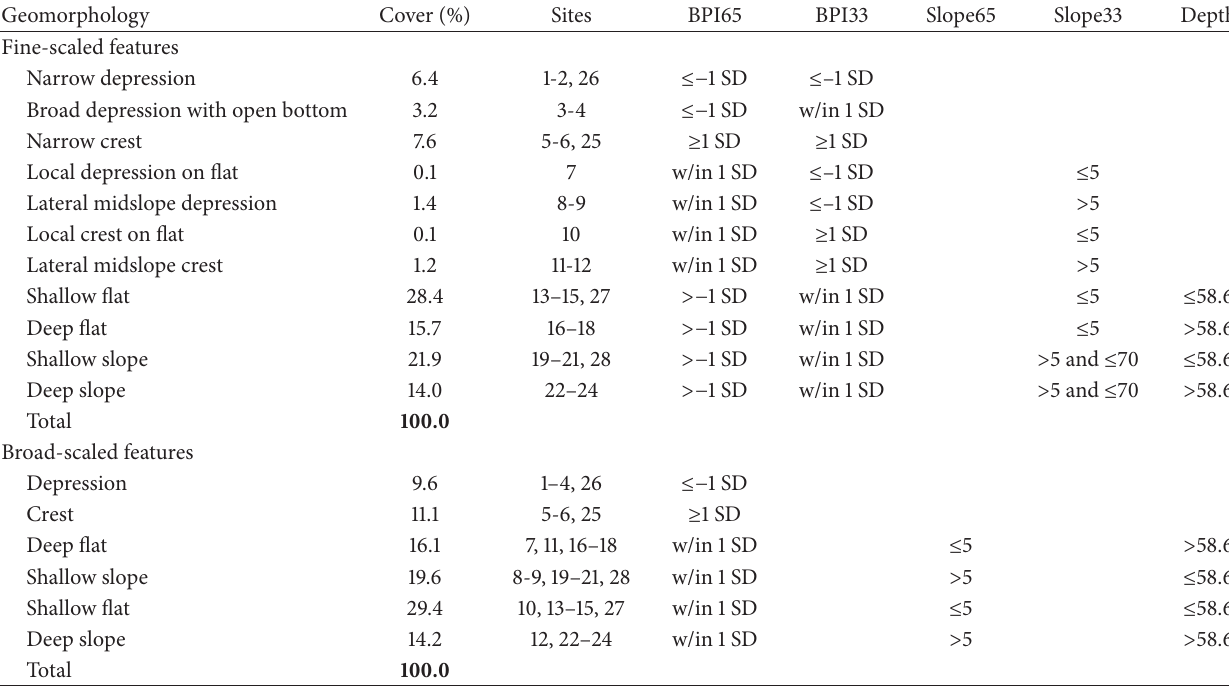
Table 1: Sampling of sites based on stratified random sampling of geomorphological features. The classification into geomorphological features was based on a slightly modified version of an algorithm by Lundblad et al. [23], which takes into account fine- and broad-scaled geomorphological